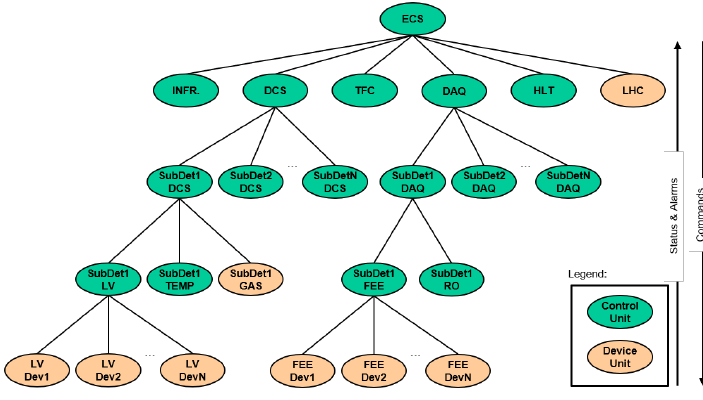
Figure 1. LHCb Run Control FSM